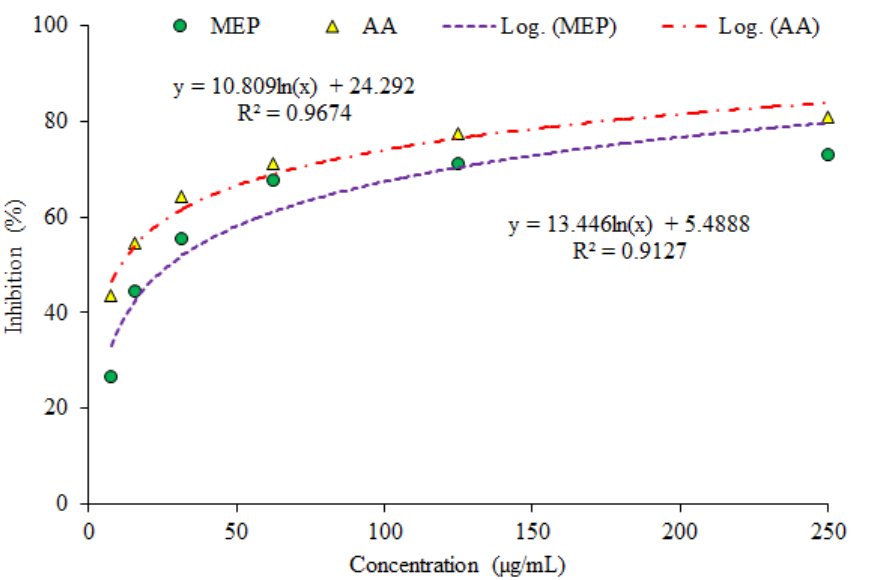
Figure 2. Percentage scavenging at various concentrations in phosphomolybdate assays (PMA) (MEP–Methanol extract of plants; AA–Ascorbic acid).